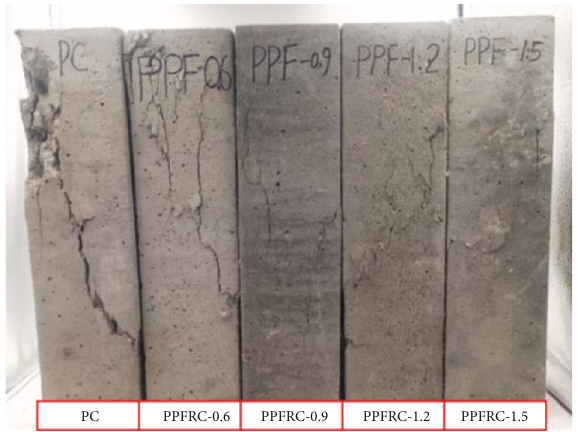
Figure 16: Uniaxial compression failure morphology of specimens at 28 days of curing age (sample 1).